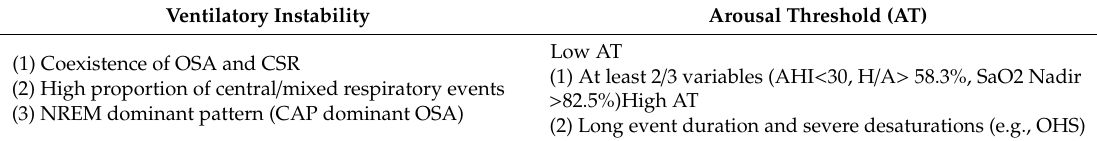
Table 3. Polysomnographic (PSG) patterns consistent with ventilatory instability and impaired AT [73].